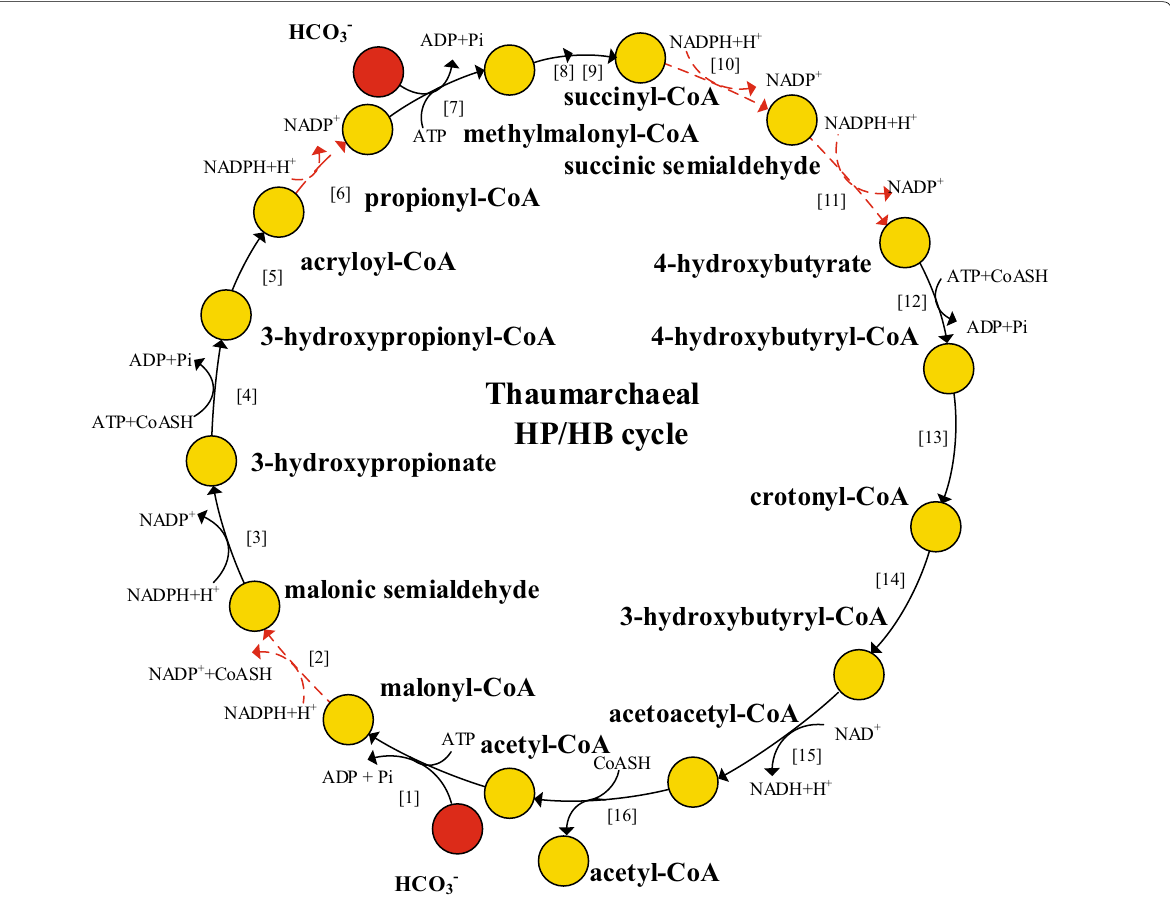
Fig. 2 The Thaumarchaeal HP/HB cycle for carbon fixation. Four missing reactions in the strain SCM1 draft model were marked in red-dashed line. Enzymes numbered in brackets are: 1, acetyl-CoA carboxylase (EC 6.4.1.2); 2, malonyl-CoA reductase (NADPH) (EC 1.2.1.75); 3, malonic semialdehyde reductase (NADPH) (EC 1.1.1.-); 4, 3-hydroxypropionyl-CoA synthetase (ADP-forming) (EC 6.2.1.-); 5, 3-hydroxypropionyl-CoA dehydratase (EC 4.2.1.116); 6, acryloyl-CoA reductase (EC 1.3.1.84); 7, propionyl-CoA carboxylase (EC 6.4.1.3); 8, methylmalonyl-CoA epimerase (EC 5.1.99.1); 9, methylmalonyl-CoA mutase (EC 5.4.99.2); 10, succinyl-CoA reductase (NADPH) (EC 1.2.1.76); 11, succinic semialdehyde reductase (NADPH) (EC 1.1.1-); 12, 4-hydroxybutyryl-CoA synthetase (ADP-forming) (EC 6.2.1.-); 13, 4-hydroxybutyryl-CoA dehydratase (EC 4.2.1.20); 14, crotonyl-CoA hydratase [(S)-3-hydroxybutyryl-CoA forming] (EC 4.2.1.17) 15, (S)-3-hydroxybutyryl-CoA dehydrogenase (NAD β-ketothiolase (EC